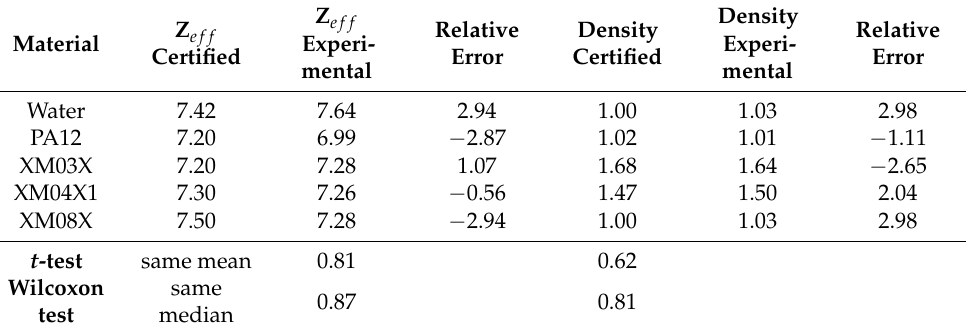
Figure 6. The certified and experimentally determined density values ( a ) and effective atomic number ( b ) of water, PA12 (polyamide 12 known as nylon 12), and explosive simulants XM03X, XM04X1, as well as XM08X. Table 4. The effective atomic number, density (in gcm − 3 ) of the materials used for validation, as well as the probability, the experimentally, and the calibrated parameters to be the same according to Student t (same mean) and Wilcoxon (same median) tests. The relative error in determining both parameters is expressed in